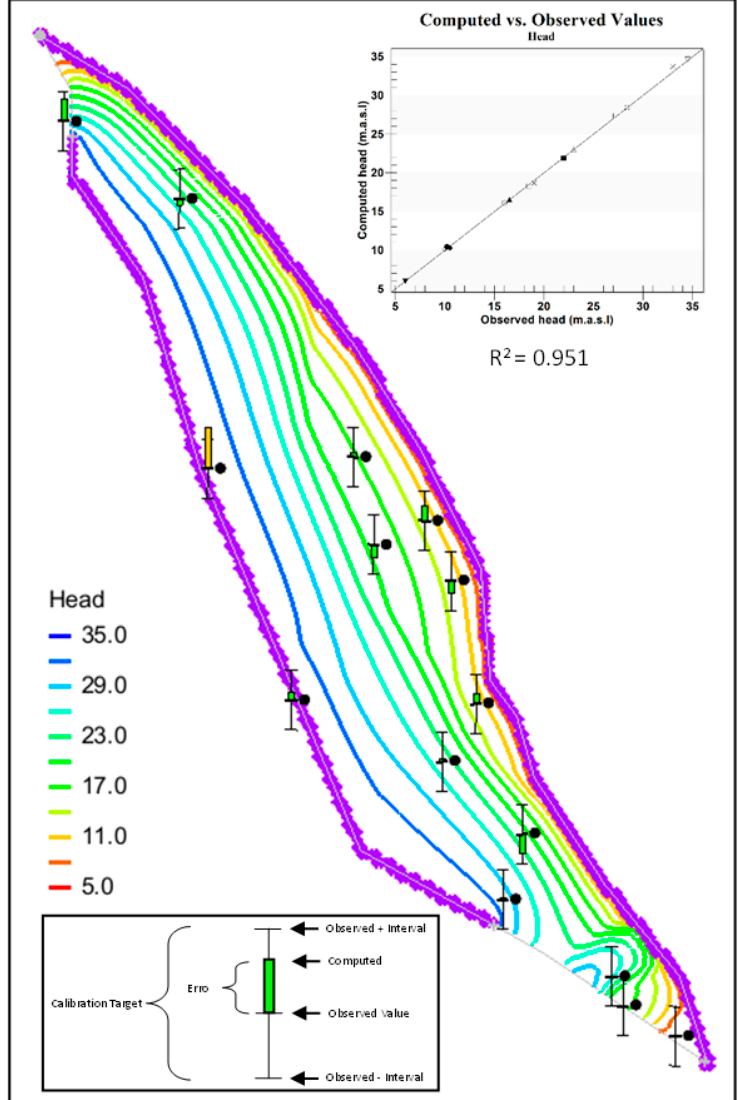
Figure 6. Contour map of the simulated groundwater level in meters above sea level (m.a.s.l.) after calibration of the Dibdibba aquifer under steady-state conditions.